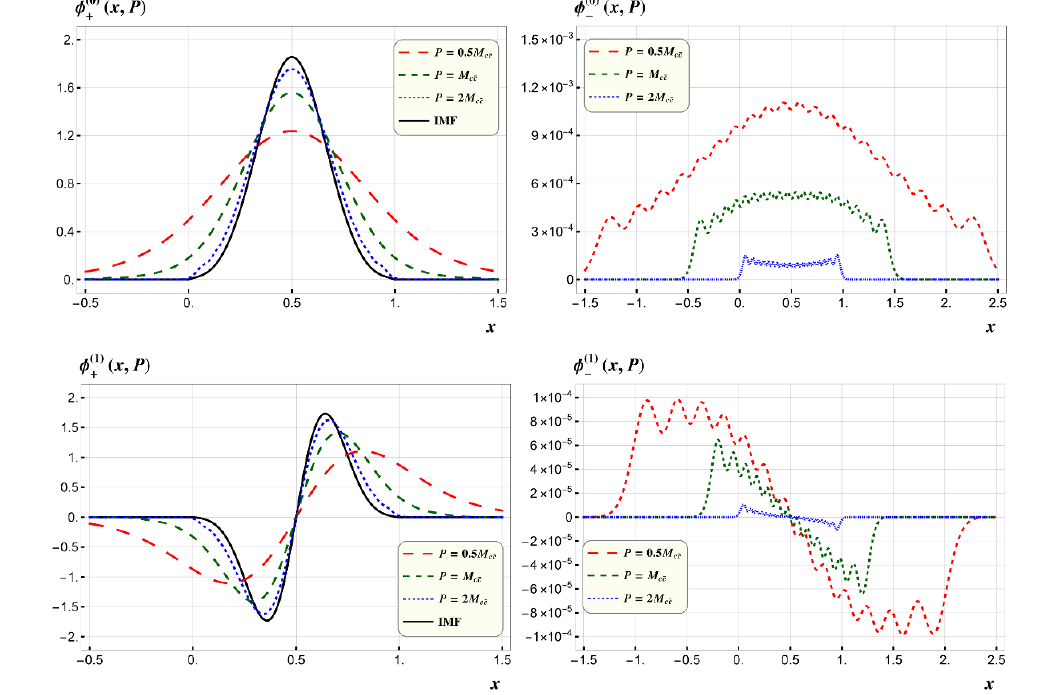
Figure 11 . Bars-Green wave functions for the low-lying charmonium states with m c = 4 : 23: ground state ((cid:12)rst row), and the (cid:12)rst excited state (second row).